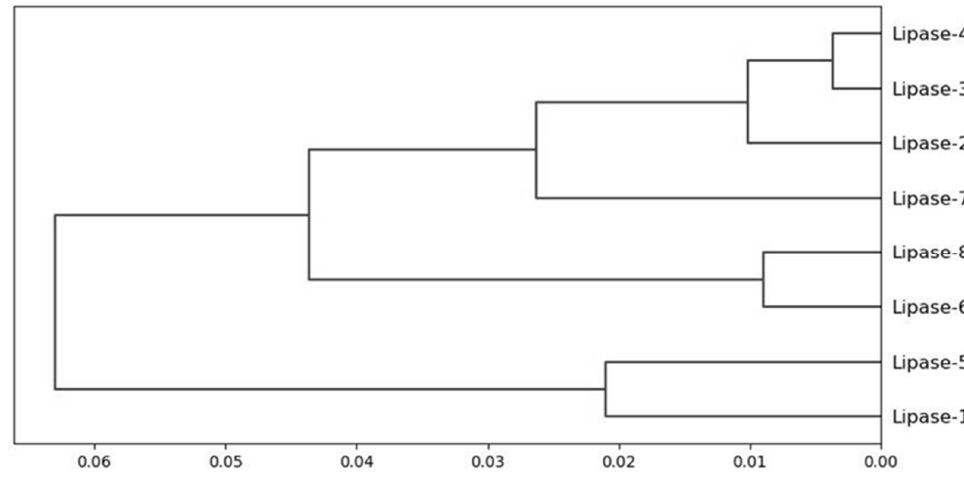
Figure 3. The hierarchical clustering of Amycolatopsis eburnea lipases is based on solvent surface accessibility area.